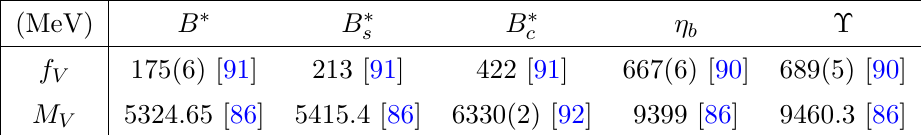
Table 8 . Decay constants and masses for the vectorial B mesons